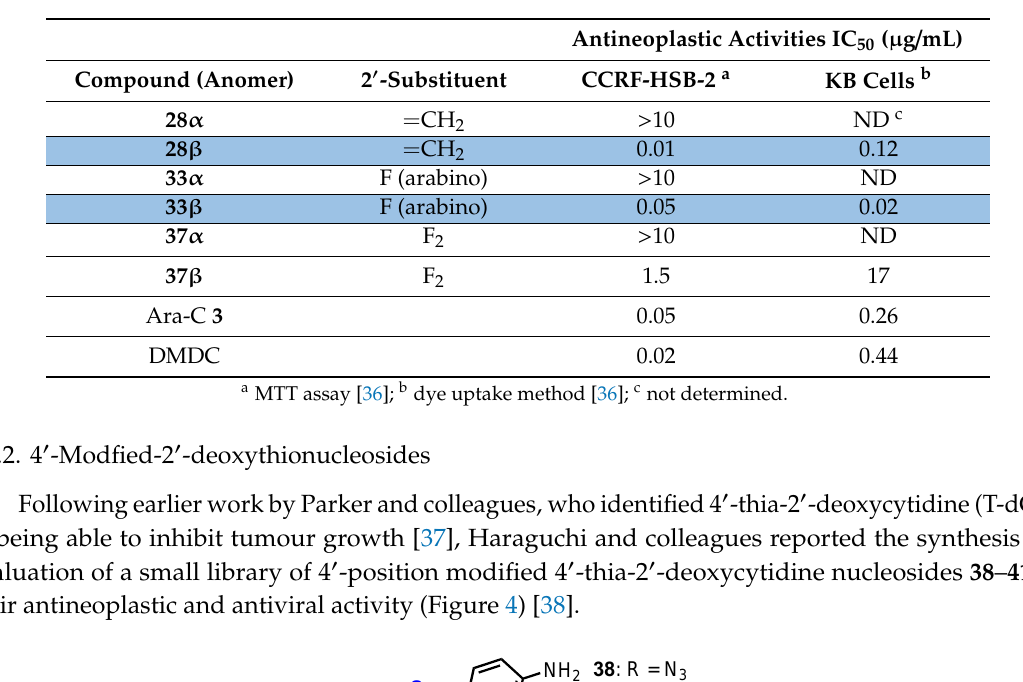
Table 1. Antineoplastic activities of 2′ -modified- 4′ -thionucleosides.